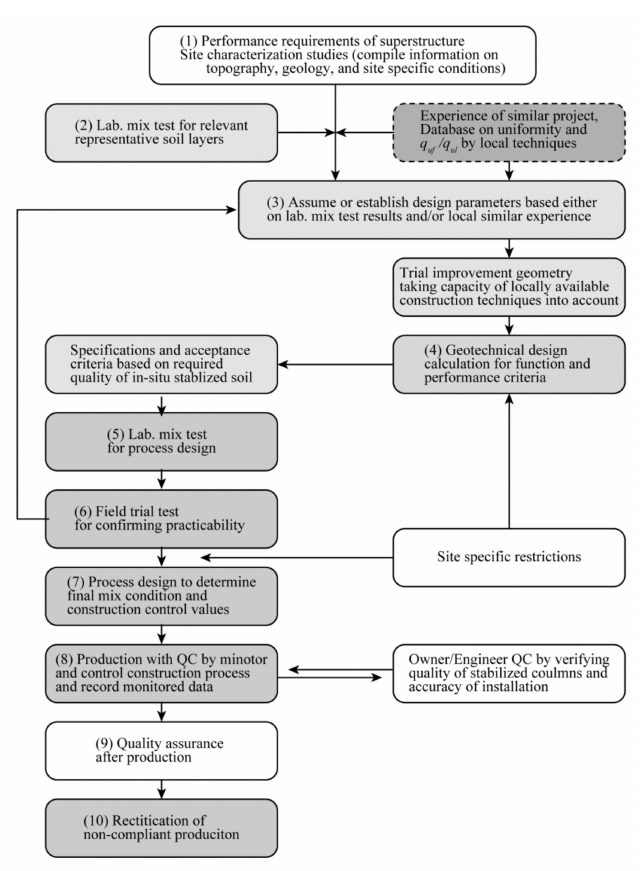
Figure 4. Flow of the deep mixing project and QC/QA (after